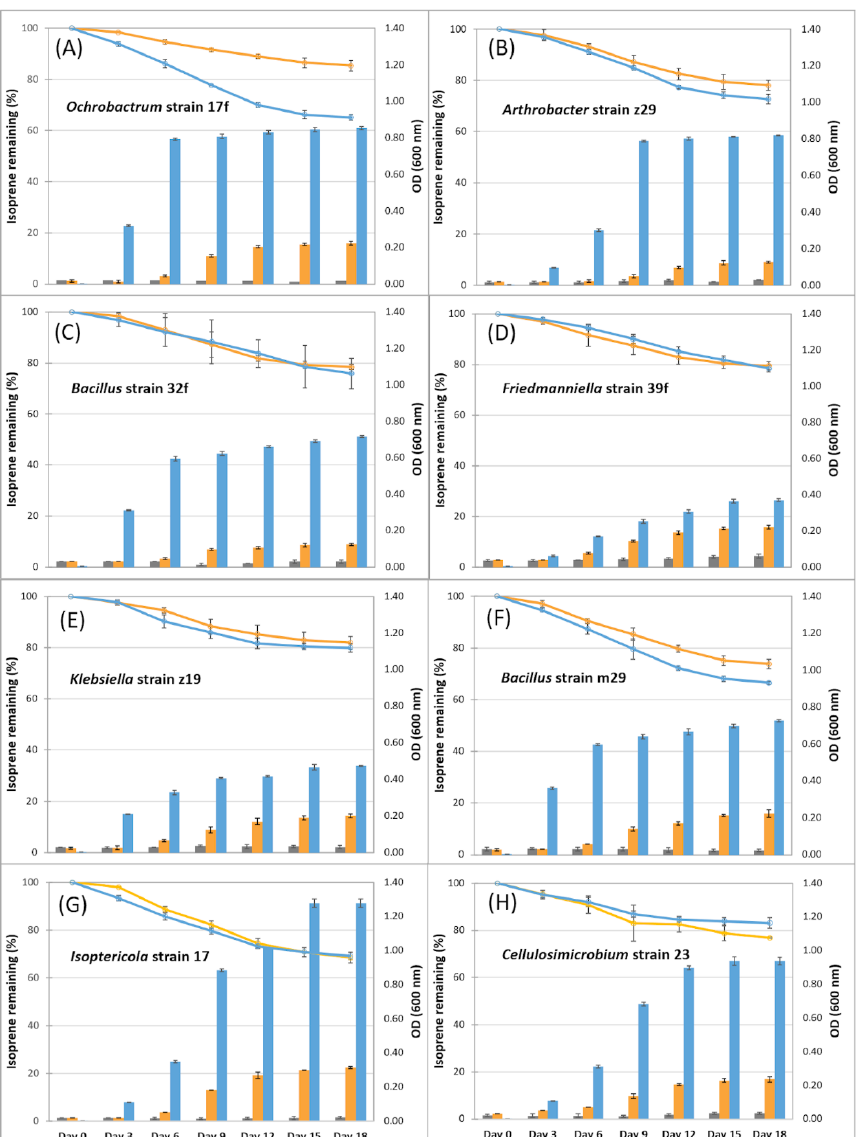
Figure 5. Growth and isoprene degradation by bacteria isolated from soil samples ( A – H show data from eight different isolates). The growth of isolates, measured by OD 600 , is shown for: minimal medium only (grey bars, scale exaggerated 10- fold), minimal medium with isoprene (orange bars, scale exaggerated 10-fold) and glucose/yeast medium with isoprene (blue bars). Isoprene was supplied at 7.2 × 10 5 ppbv). Degradation is shown by the percentage of isoprene remaining in cultures grown in minimal medium supplied with isoprene (orange lines) and glucose/yeast medium with isoprene (blue lines). n = 3. Error bars show ±SD.